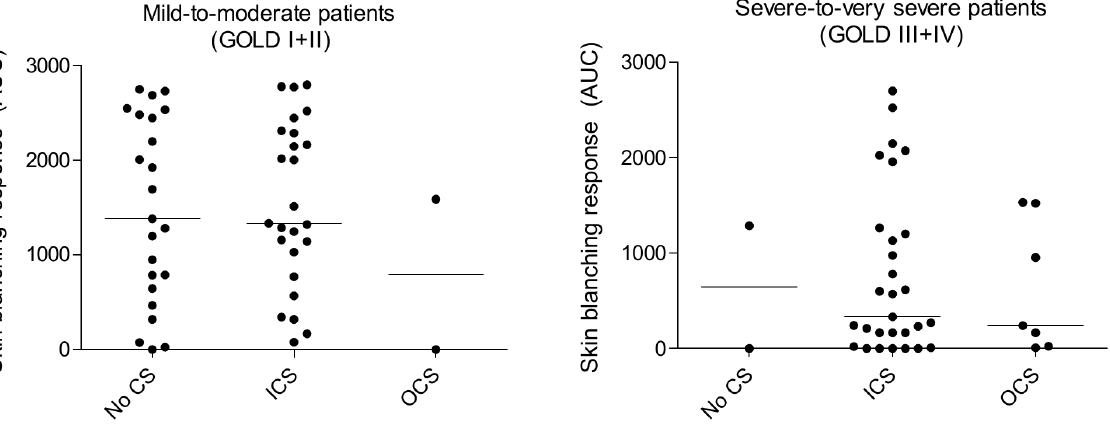
Figure 4. Corticosteroid treatment and skin blanching response in COPD patients. AUC = area under the dose-response curve, CS = corticosteroids, ICS = inhaled corticosteroids, OCS = oral